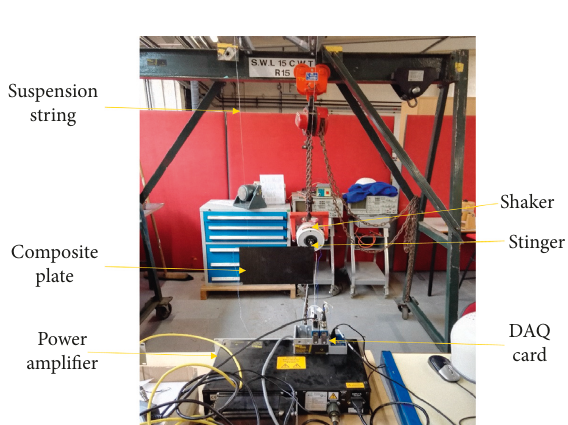
Figure 3: Static